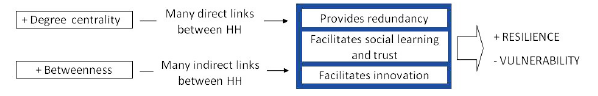
Fig. 2 . How social network structure impacts resilience and